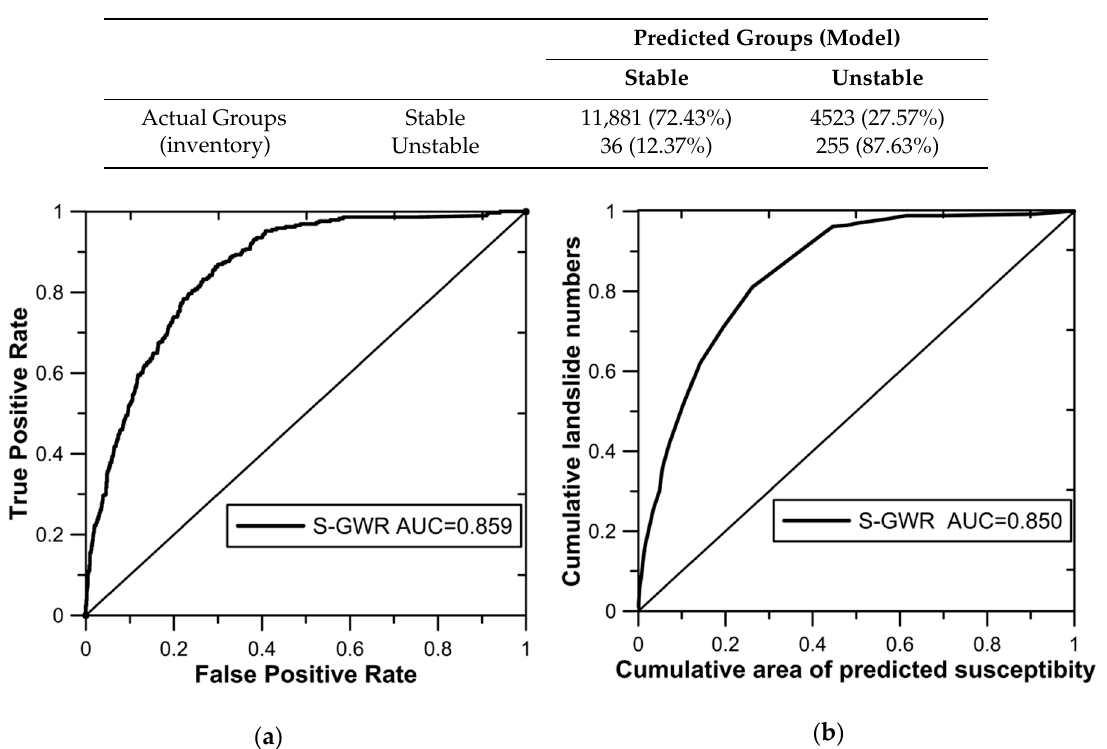
Table 4. Sample evaluation contingency table of the proposed S-GWR model.